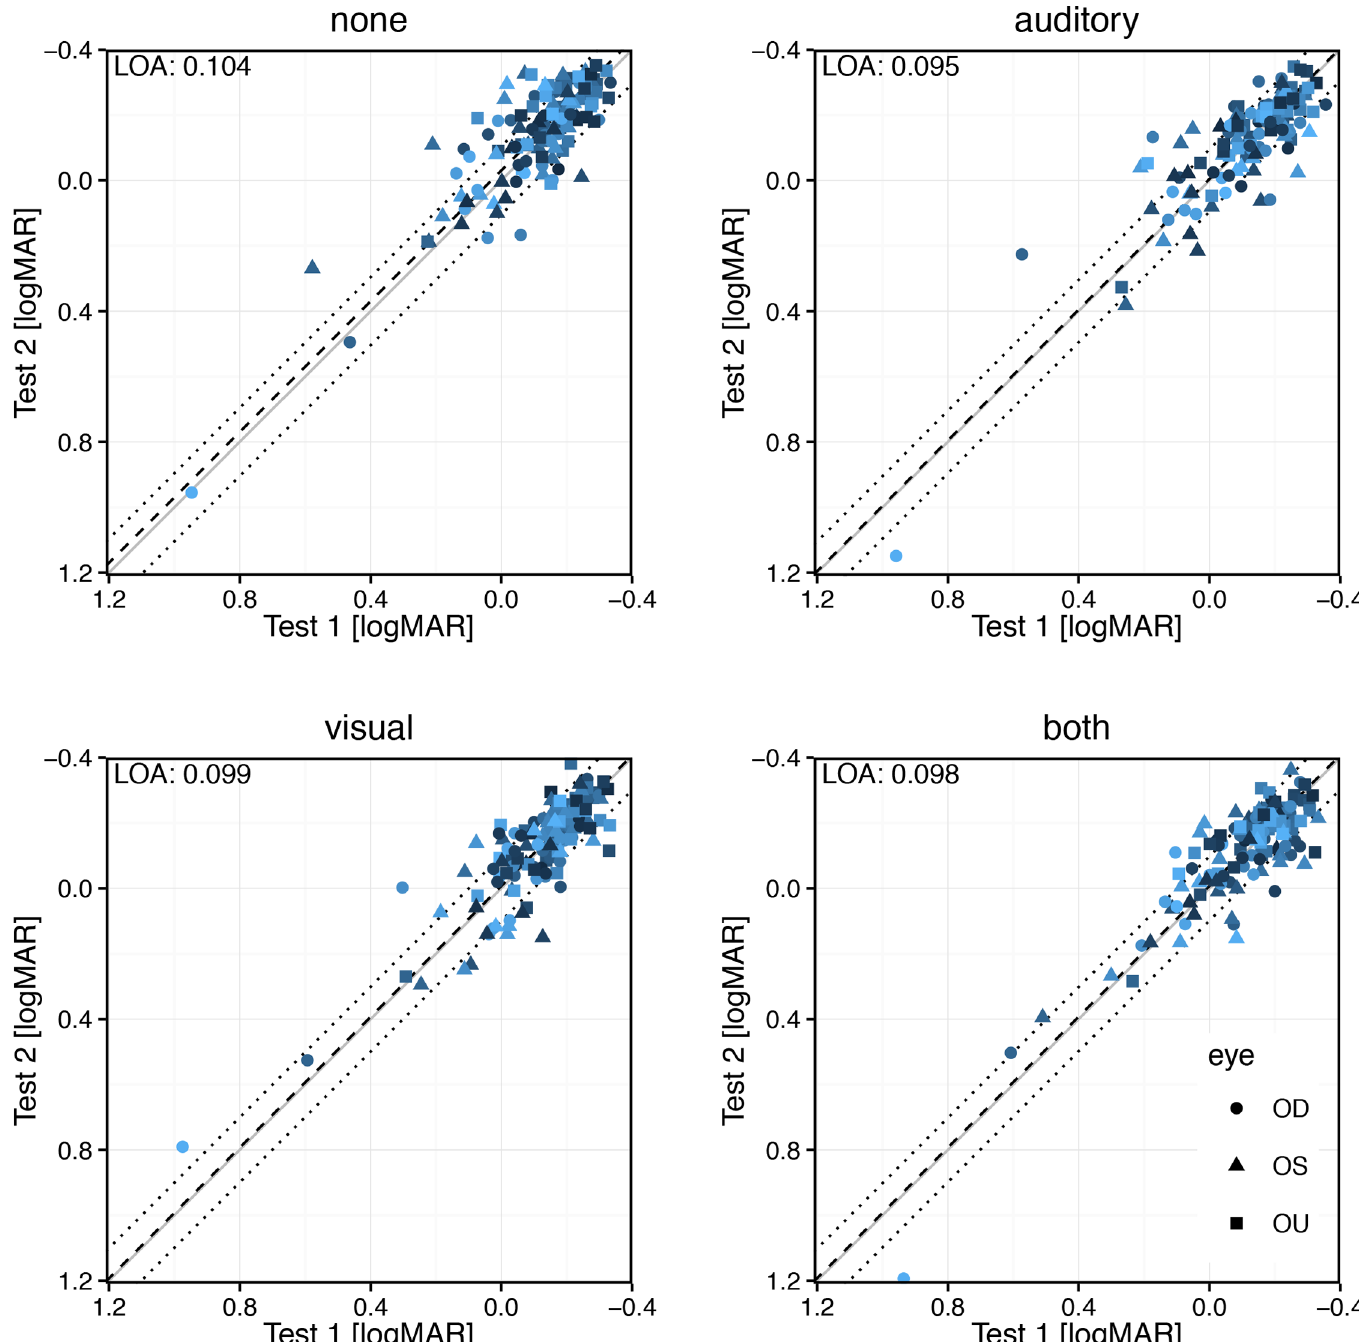
Fig 4. Test-retest agreement across feedback conditions. The identity line is indicated by a solid gray line. Symbol color varies by participant to better unconfound overplotting. The dashed line represents the mean difference, the dotted lines the limits of agreement (LOA, Eq (1)) which are also enumerated at top left. The LOAs are quite low ( (cid:4) 0.1 logMAR) and closely similar across conditions. Thus the type of feedback does not influence test-retest agreement. The mean differences are always slightly above the identity line, indicating a slight learning effect (see Discussion).